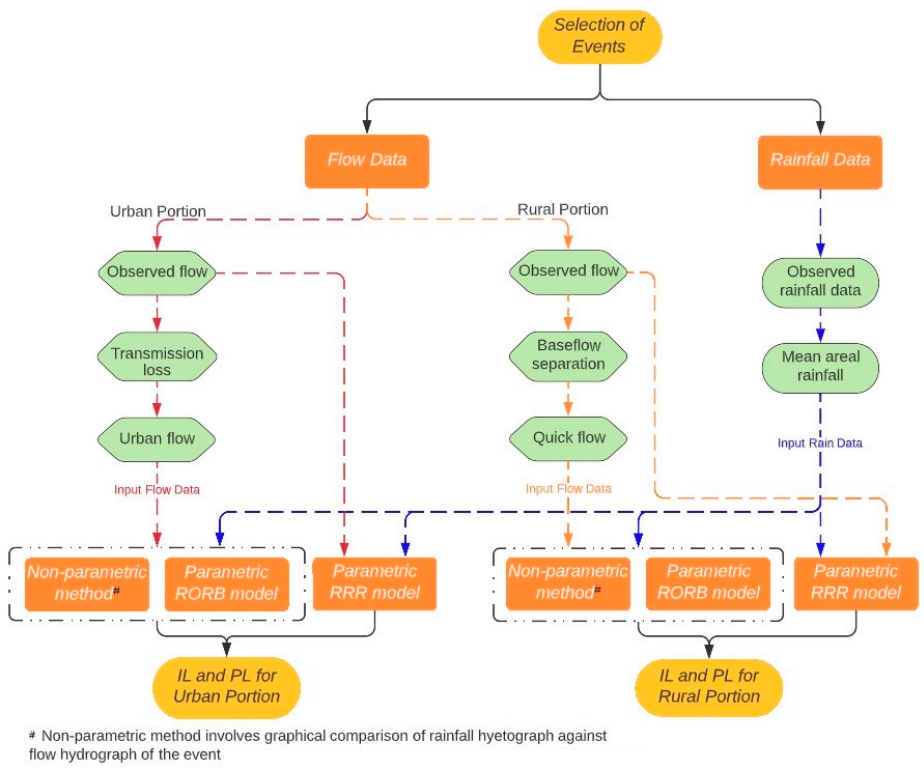
Figure 3. Approach of estimating IL and PL for the BHC catchment .